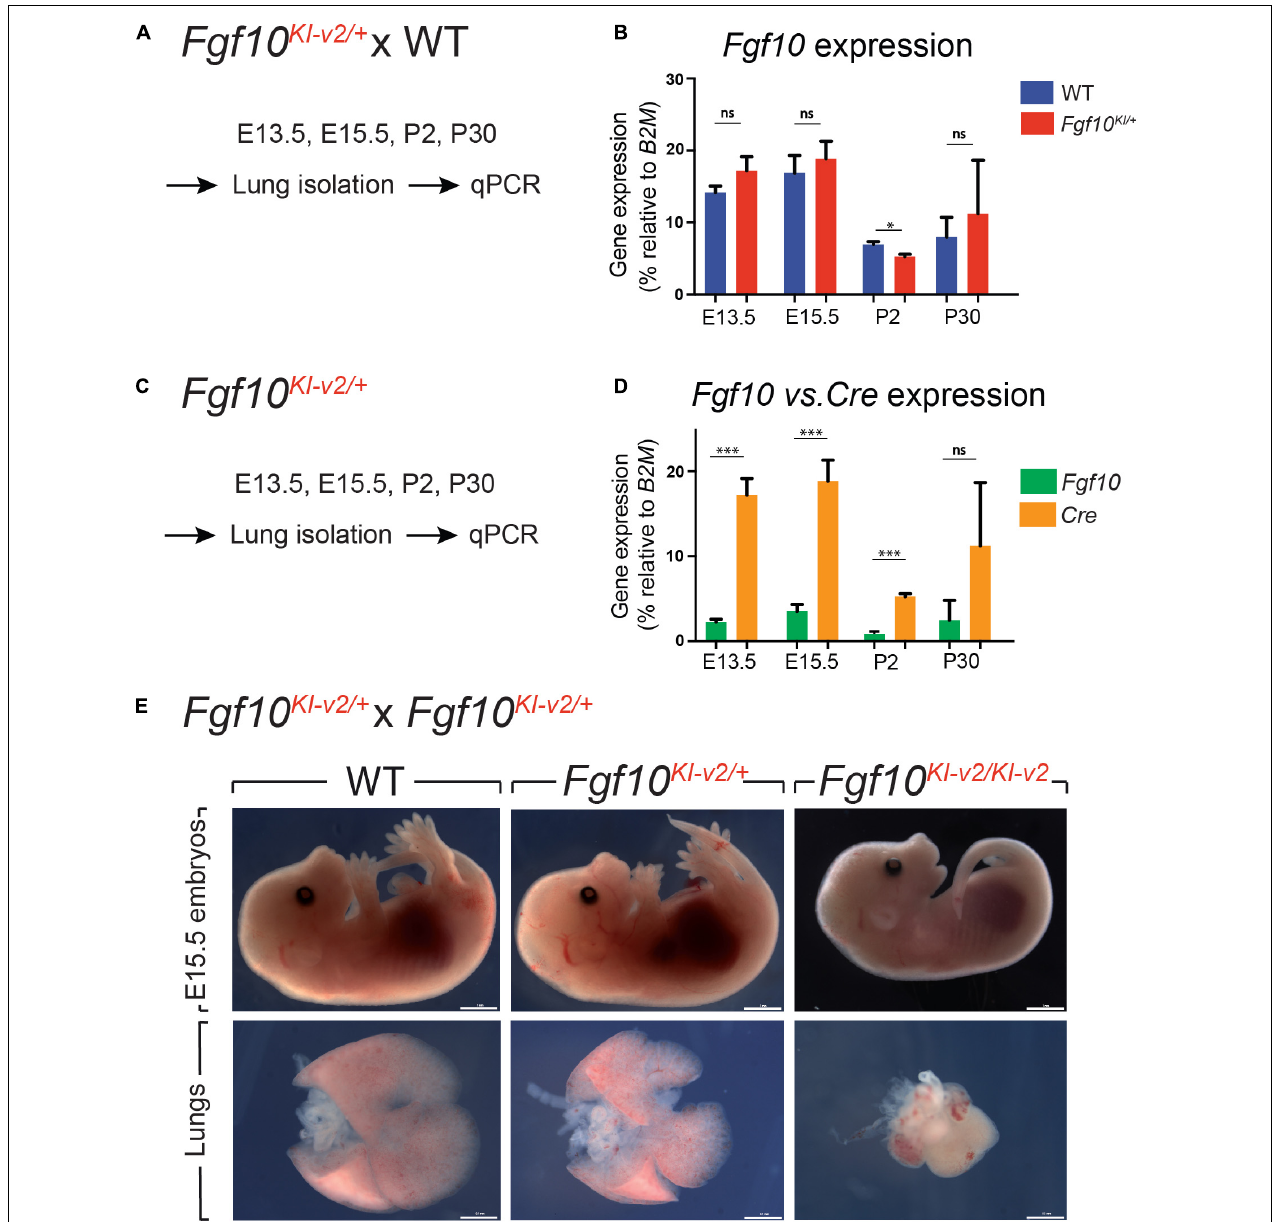
FIGURE 2 | Fgf10 Ki - v 2 is a loss-of-function allele. (A) Fgf10 Ki - v 2 / + and Fgf10 + / + mice were crossed and lungs were isolated at E13.5, E15.5, P2, and P30 for qPCR analysis. (B) qPCR results for Fgf10 expression in Fgf10 + / + and Fgf10 Ki - v 2 / + at these time points. (C,D) Lungs were isolated from Fgf10 Ki - v 2 / + at different time points and the expression levels of Fgf10 and Cre were analyzed by qPCR. (E) Fgf10 Ki - v 2 / + animals were crossed to generate Fgf10 + / + , Fgf10 Ki - v 2 / + , and Fgf10 Ki - v 2 / Ki - v 2 embryos at E13.5. Note the absence of limbs and lungs in the Fgf10 Ki - v 2 / Ki - v 2 embryos. Scale bar in (E) : whole embryo: 1 mm; dissected lungs: 0.1 mm. * P ≤ 0.05, *** P ≤